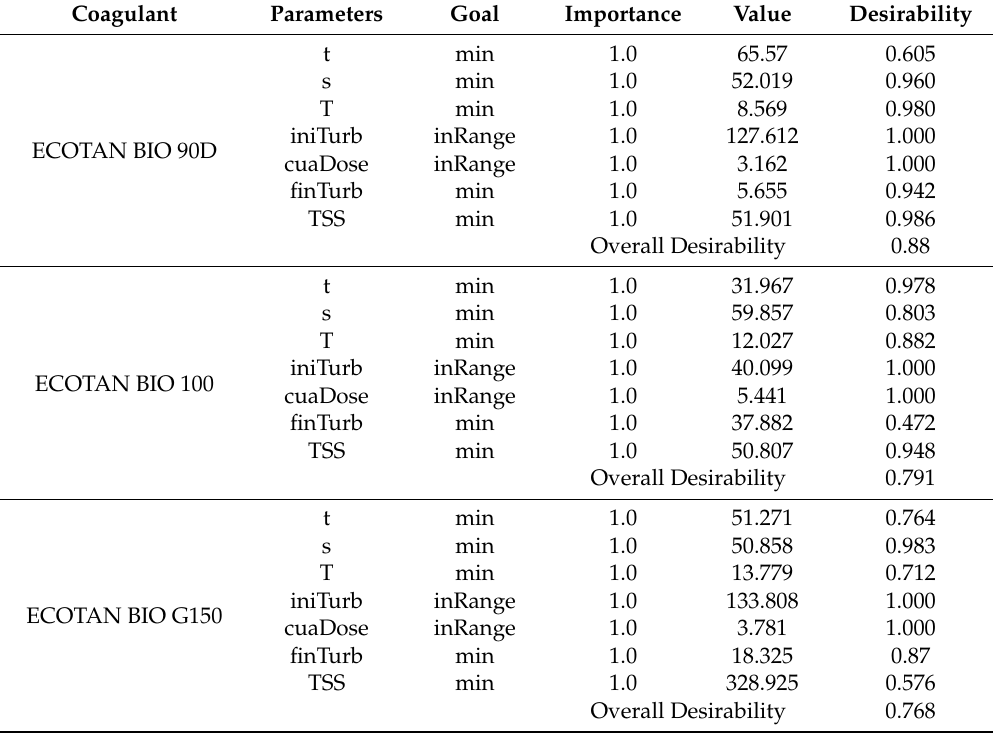
Table 15. The second clarification optimization scenario: the energy consumption is minimized to obtain the highest efficiency of turbidity removal and